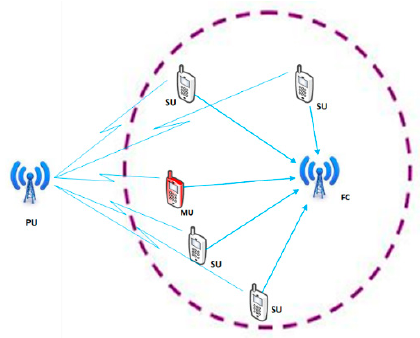
Figure 1. System model.